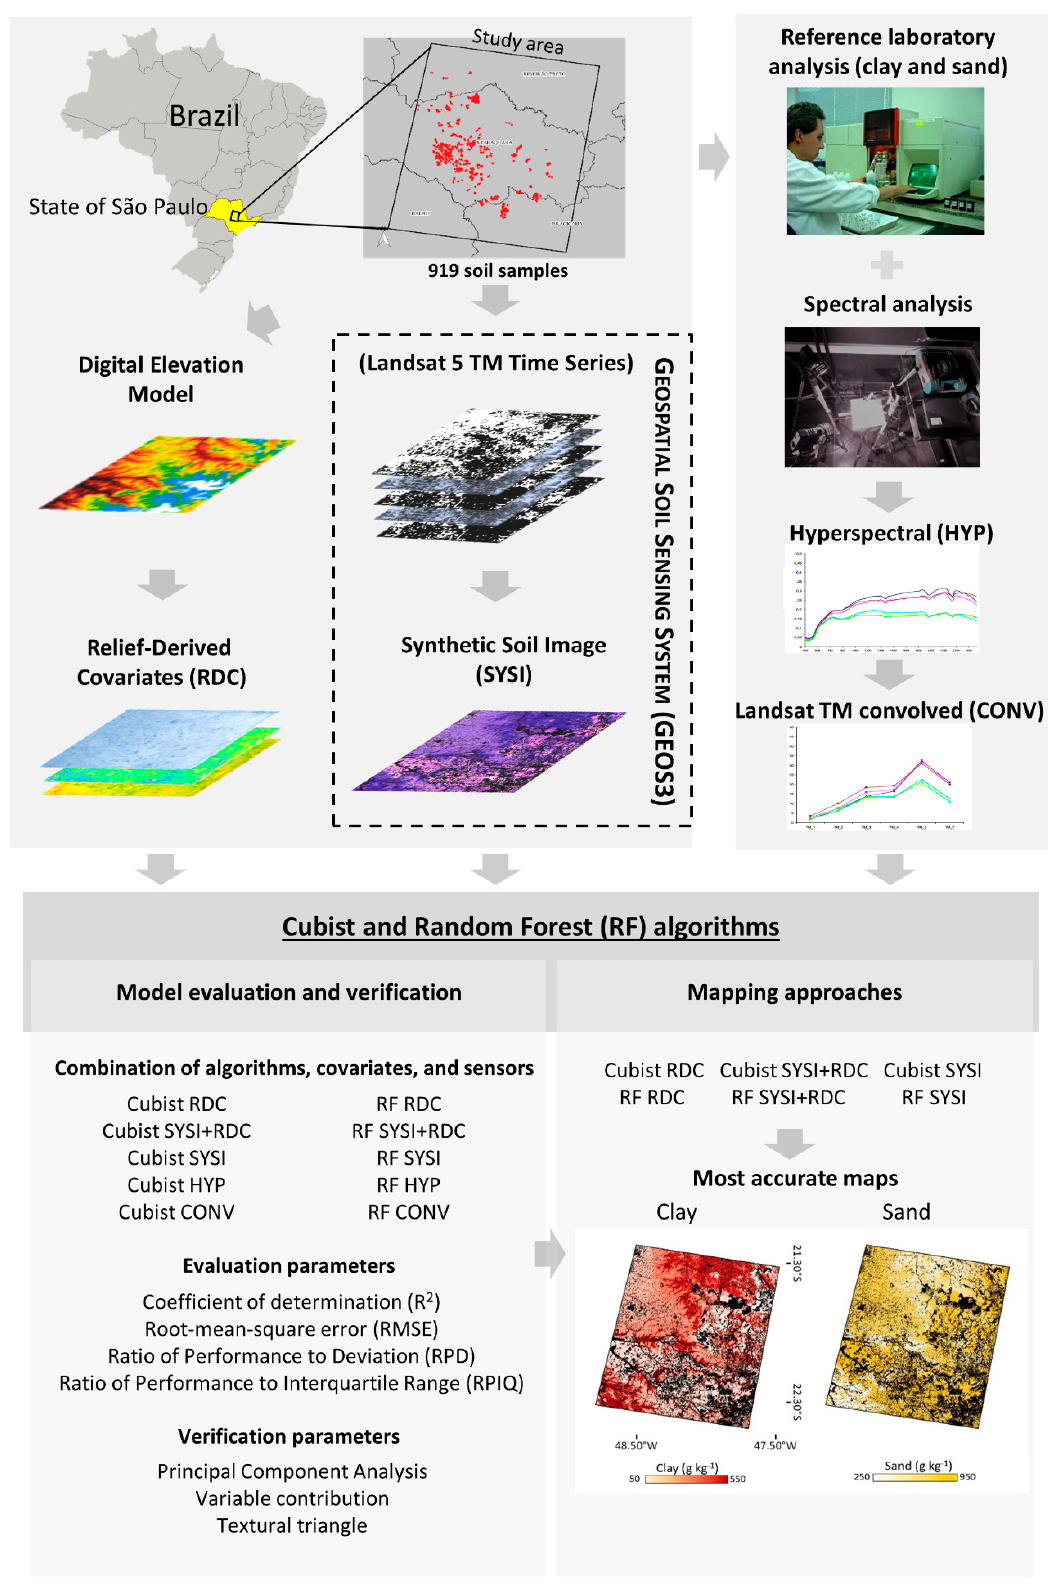
Figure 1. Flowchart showing the study area within the São Paulo State, Brazil, and the methodology applied.